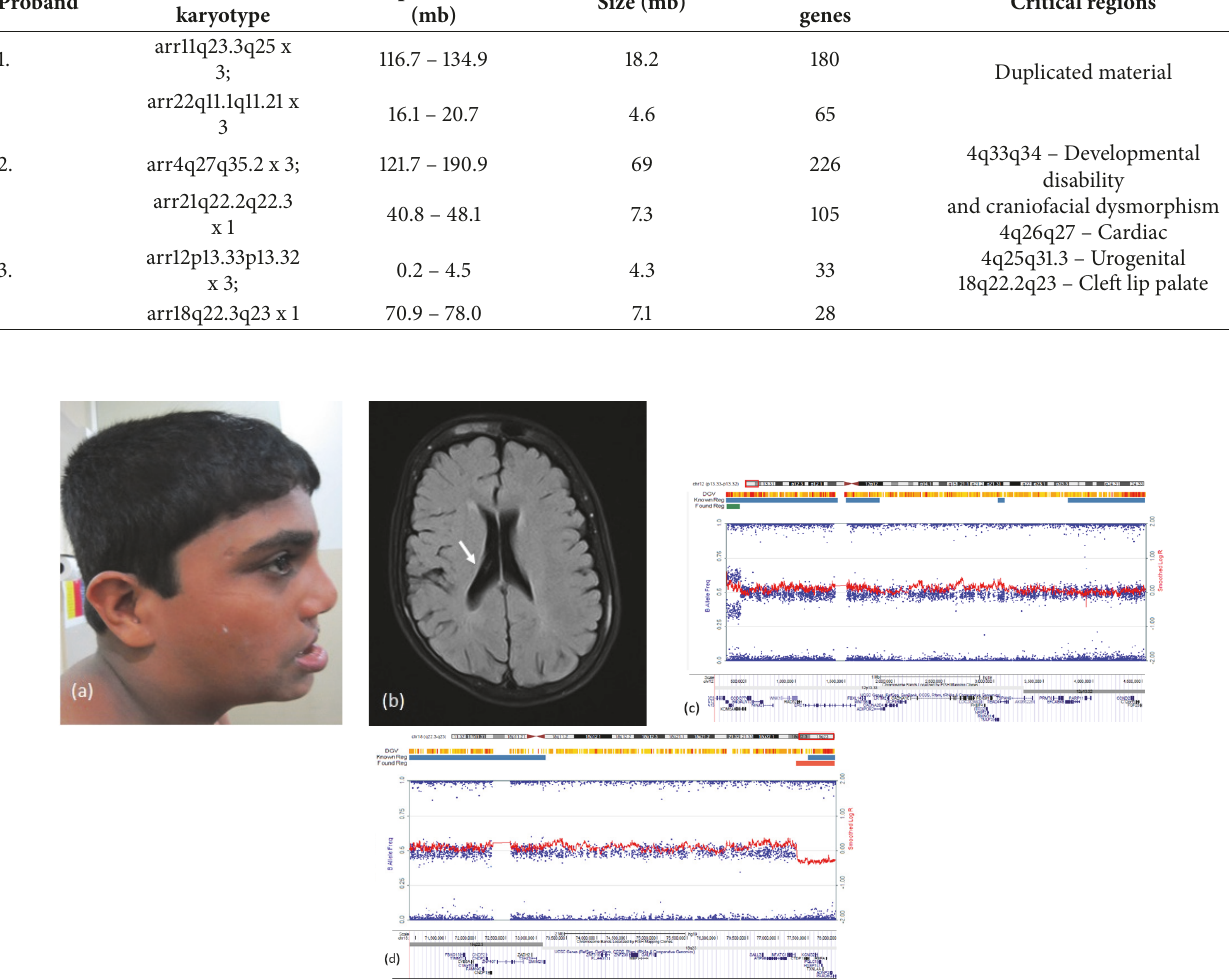
Figure 3: Proband 3: (a) phenotype showing low set ears and everted lower lip, (b) T2 weighted magnetic resonance imaging of brain showing asymmetric lateral ventricle (arrow), (c) snapshots of microarray plots (Illumina HumanCytoSNP-12, CA) and coding genes (http://genome.ucsc.edu/)ofduplication12p13.33p13.32,and(d)snapshotsofmicroarrayplots(IlluminaHumanCytoSNP-12,CA)andcoding genes (http://genome.ucsc.edu/) of deletion 18q22.3q23.